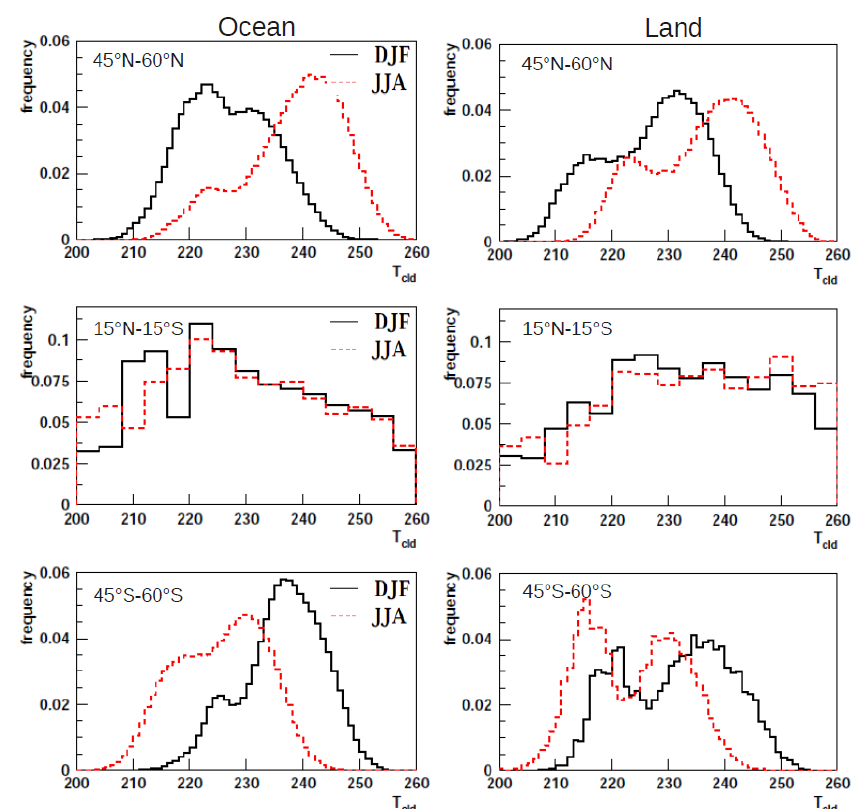
Fig. 7. Normalized frequency distributions of high cloud temperature (in Kelvin) over ocean (left) and over land (right), separately for three latitude bands. Boreal winter and boreal summer are represented with black and red lines, respectively. Statistics is over the period 2003 - 2009.